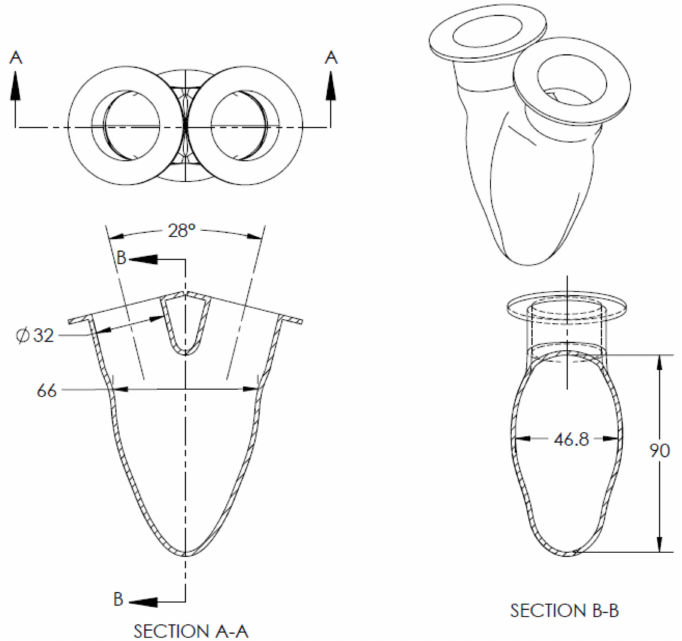
Figure 2. Internal dimensions of the left ventricle used in the simulator. The thickness and outer dimensions will vary depending on the number of layers of silicone applied.